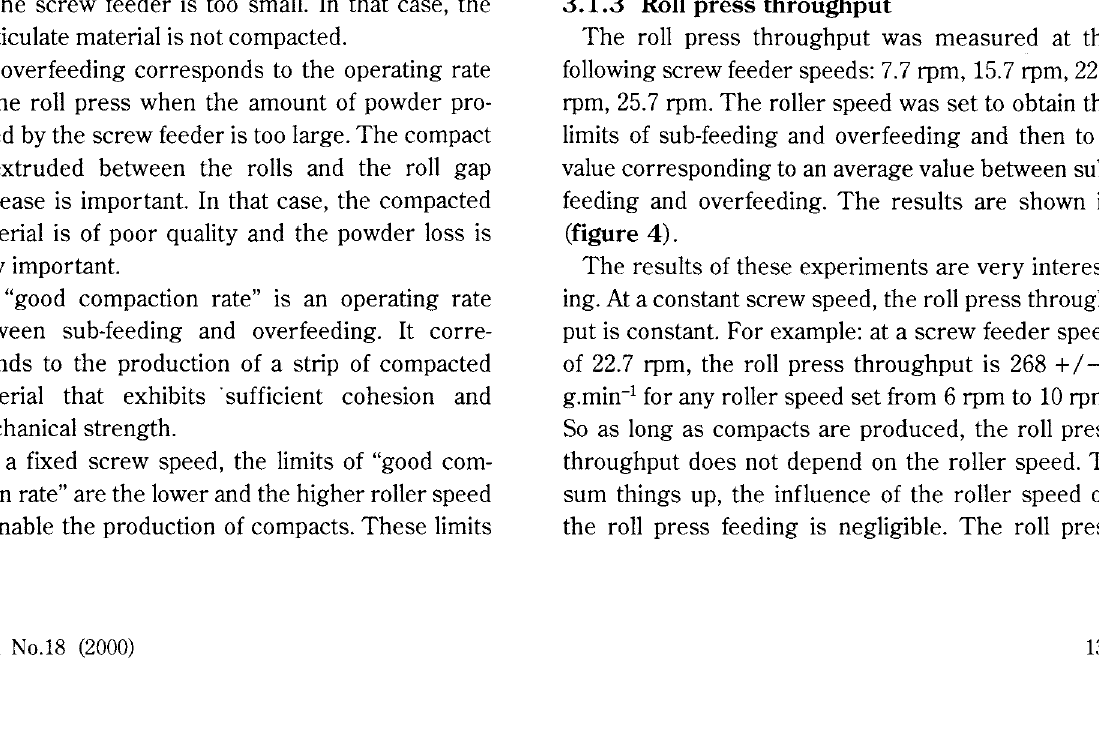
Fig. 3 Roller speed versus screw feeder speed corresponding to the limit of overfeeding and